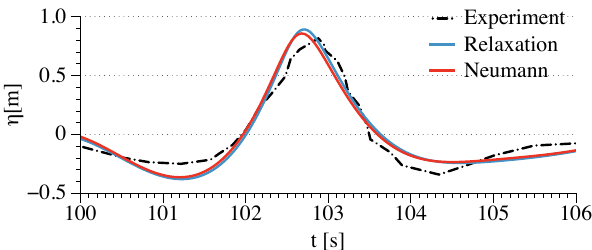
Figure 22. Comparison of the time series at the focusing location of 126.21 m generated by a relaxation method and a Neumann boundary using the wave packet input.